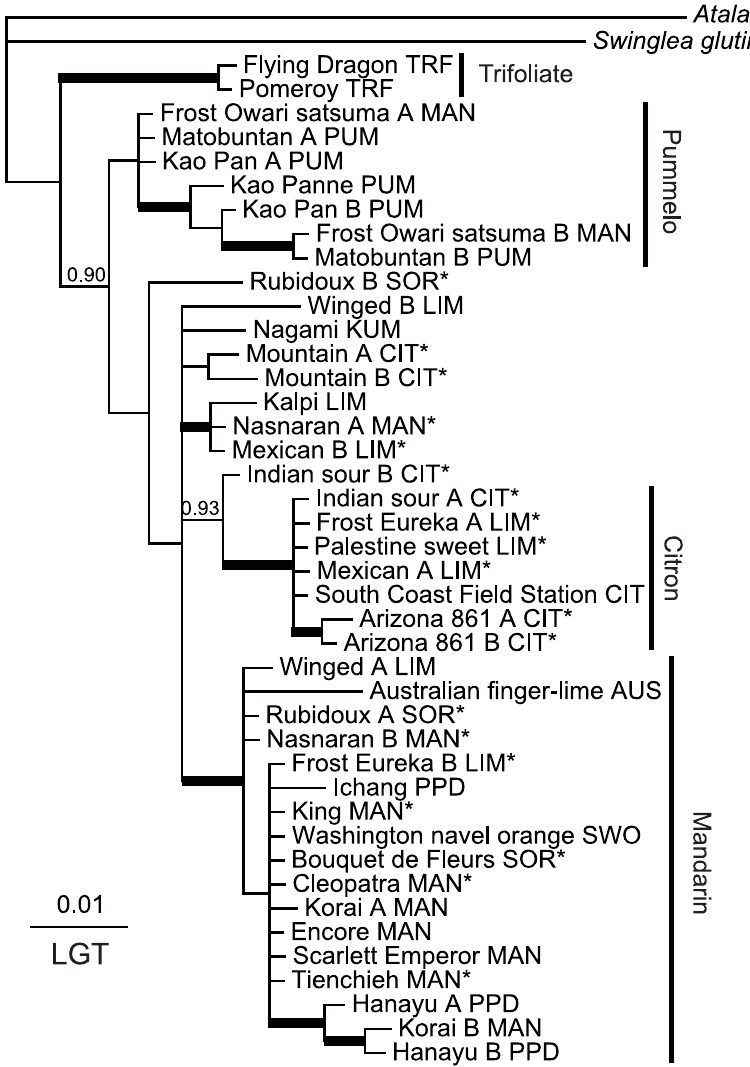
Figure 2. Bayesian consensus phylogram of LGT sequences from Citrus and related genera. Details as in Figure 1.